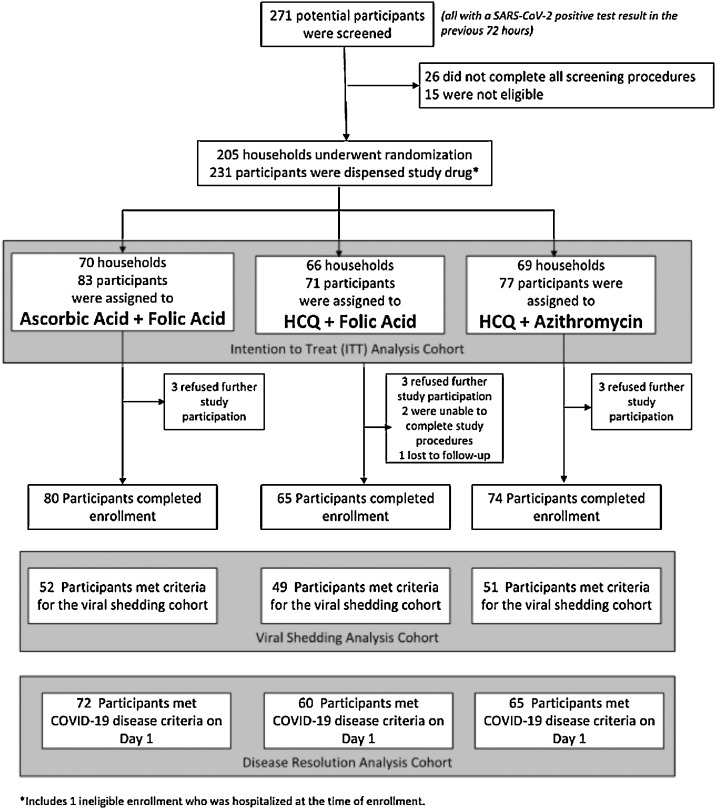
Consort diagram showing enrollment and follow up of participants.